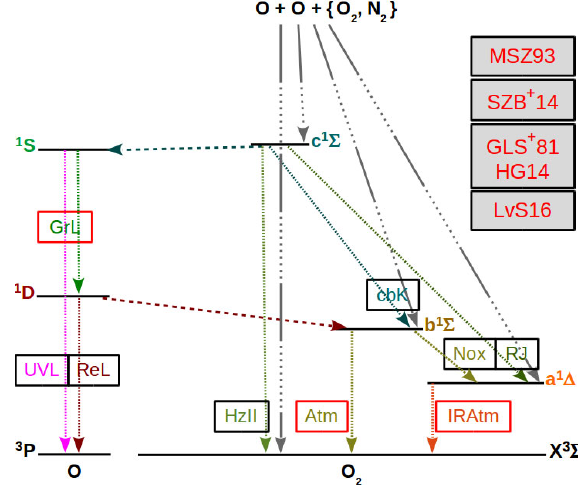
Figure 2. Similar to Fig. 1, but for processes excluding the triplet O 2 (A) and O 2 (A (cid:48) ) Herzberg states from the MAC model. All con- sidered processes of the MAC model indicated in the O 2 and O term diagrams are provided in Tables 6 and 7. The following con- clusions drawn by Slanger et al. (2004b) and Krasnopolsky (2011) help to interpret processes indicated here in the O 2 and O term di- agrams: (1) the O 2 (A, A (cid:48) ) and O 2 (X) ( X 3 (cid:54) − g ) are triplet states, which are strongly coupled with each other; (2) transitions among the singlet O 2 (c, b, a) states ( c 1 (cid:54) − u , b 1 (cid:54) + g , a 1 (cid:49) g ) and the triplet O 2 (A, A (cid:48) , X) states are less probable because they require a spin flip; (3) the O 2 (c) and O 2 (b, a) states seem to be rather weakly coupled with each other, presumably because of Franck–Condon factors. This enabled the neglect of the O 2 (A, A (cid:48) ) states in the MAC model indicated in Fig.